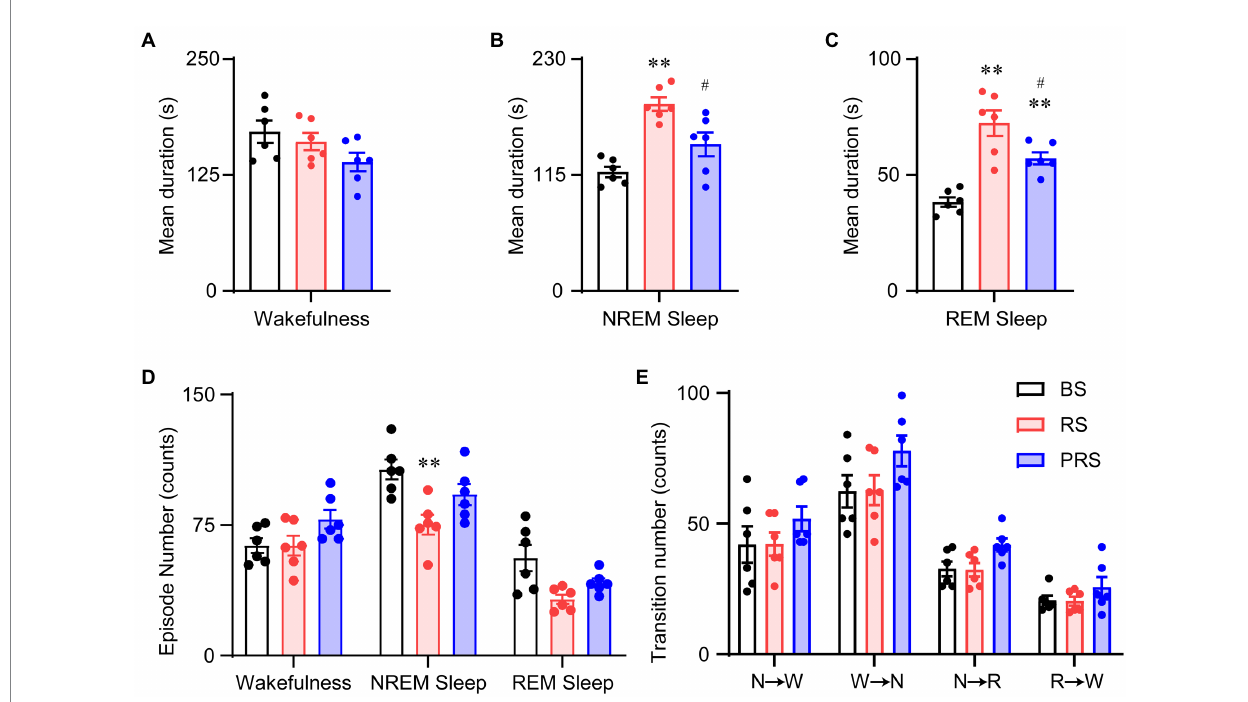
FIGURE 5 Sleep–wake architectures in the baseline, RS, and PRS groups during ZT 5–12. Mean durations of wakefulness (A) , NREM sleep (B) , REM sleep (C) , and episode numbers for each stage (D) during ZT 5–12. (E) Stage transitions between stages during ZT 5–12. ** p < 0.01 versus baseline, # p < 0.05 versus RS, n = 6. BS, baseline; RS, restraint stress; PRS, post-restraint stress; R, REM sleep; S, NREM sleep; W,